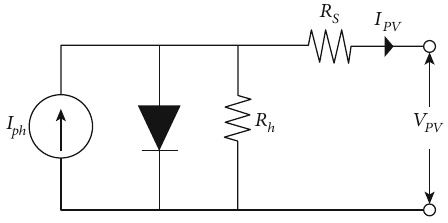
Figure 1: Equivalent circuit of PV